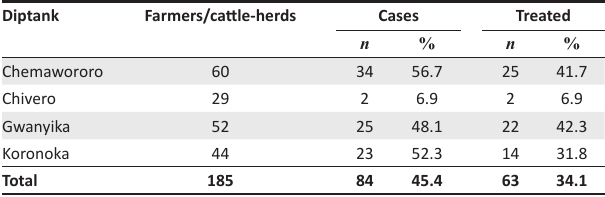
TABLE 1: Number of respondents, herds affected and farmers who treat for dermatophilosis. Diptank Farmers/cattle-herds